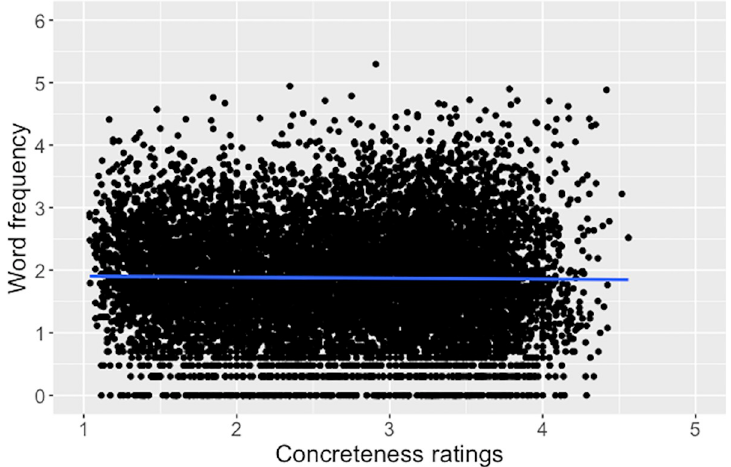
Fig 9. Correlation of the present concreteness ratings and word frequency [36], r = -.01, p =